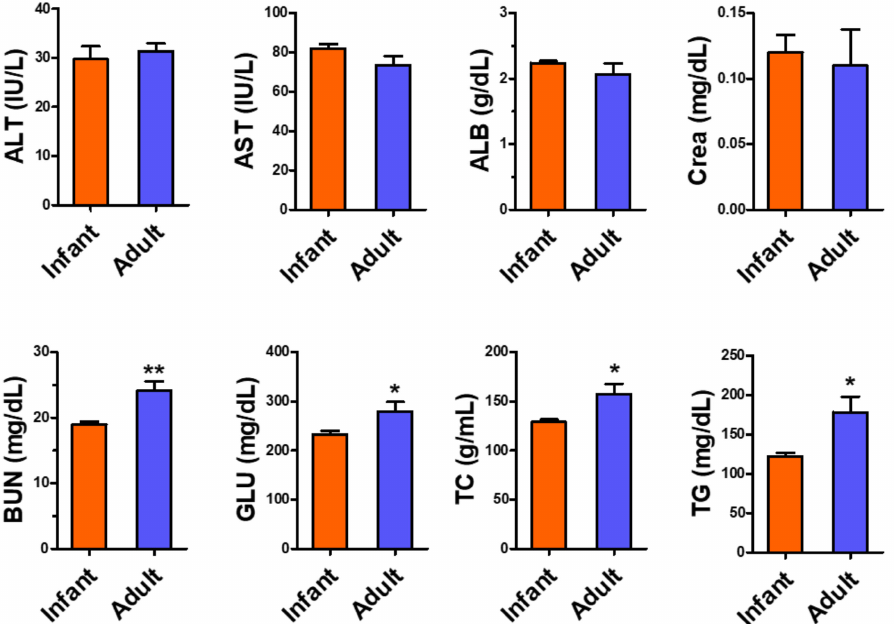
Figure 2. Serum biomarkers of infant (3-week-old, n = 9) and adult (9-week-old, n = 9) male mice. Data are presented as mean ± SE. Student’s t -test, *,** p < 0.05, and 0.01, respectively, vs infant. ALT, alanine transaminase; AST, aspartate transaminase; ALB, albumin; Crea, creatinine; BUN, blood urea nitrogen; GLU, glucose; TC, total cholesterol; TG,